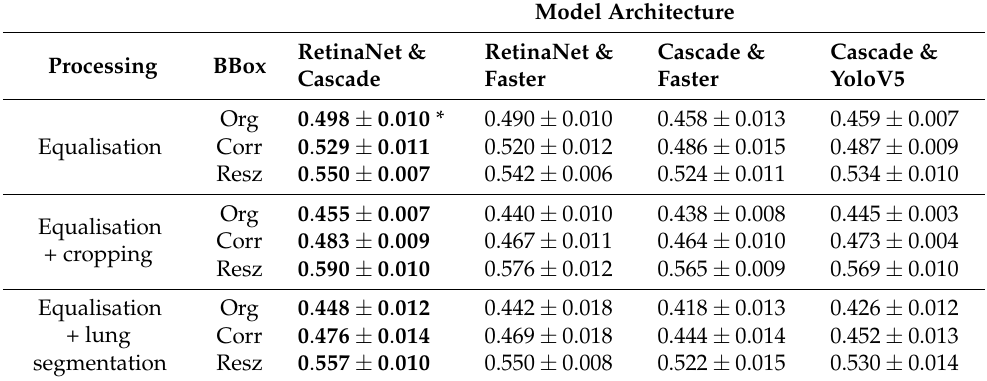
Table 6. Performance of the different model ensembles for different pre-processing strategies, eval- uation procedures and a semi-supervised approach. The BBox column has the same meaning as in Table 2.